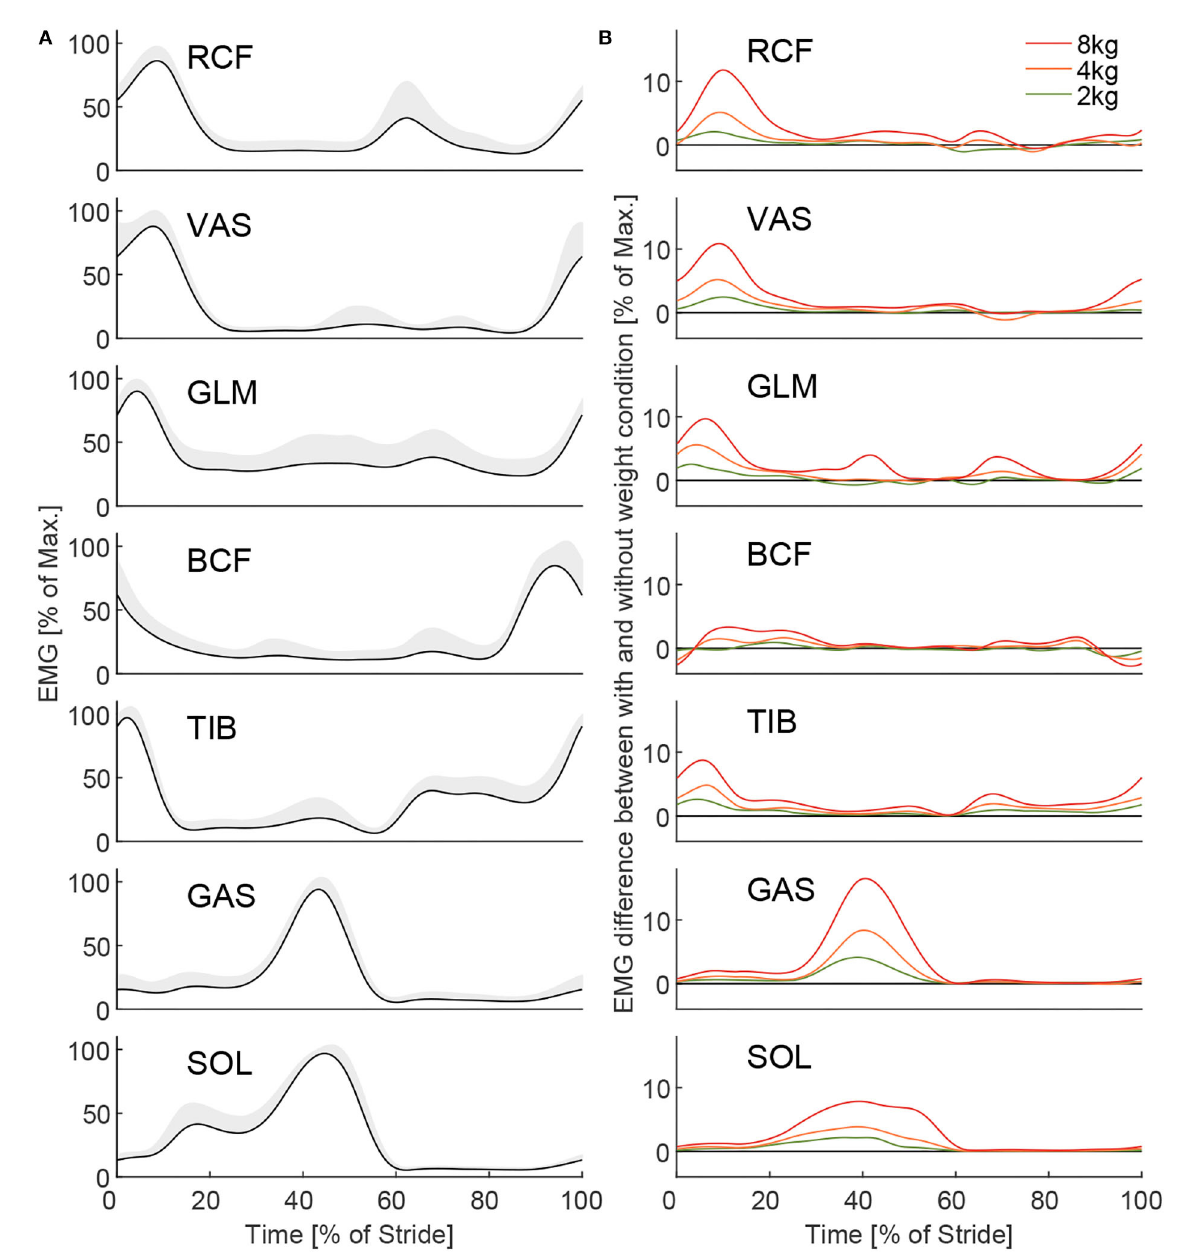
FIGURE5 The Grand mean of the EMG for all muscles [ (A) , left and right limbs combined] and EMG difference between the loaded and unloaded conditions (B) for 2, 4, and 8kg. The grand mean is the mean of all subjects, strides, and intervals of the unloaded conditions from all three experimental sessions after the Warmup. Hundred percent represents the subjects’ individual muscle maximum necessary for unloaded walking on average within the first interval of the first session after the Warmup. The gray shaded area indicates the inter-subject SD. Differences (B) between the loaded and unloaded conditions were determined based on the means (all intervals) of each condition for the same session. To note, due to a low signal-to-noise ratio some muscles [ (A) , e.g., GLM] have a larger offset from zero, which does not necessarily indicate